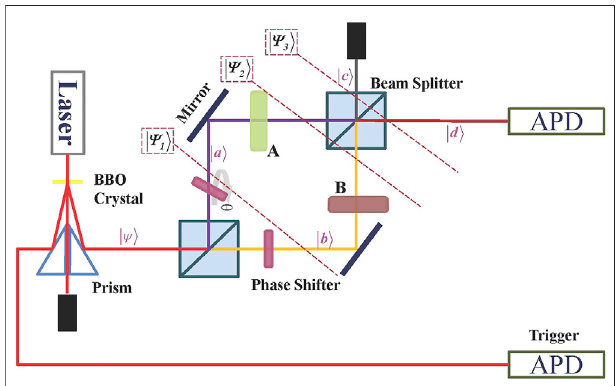
FIGURE 1 | This scheme can test the uncertainty relation for two non- Hermitian operators ( A and B ) by using the Mach – Zehnder interferometer. Pairs of single photons are generated using a BBO crystal. The signal single- photon state is prepared in | ψ 〉 . After entering a displaced Mach – Zehnder interferometer at a 5050 beam splitter, the photon traverses the interferometer. B in the transmitted arm is represented in ( yellow ), and A in the re fl ected arm is represented in ( purple